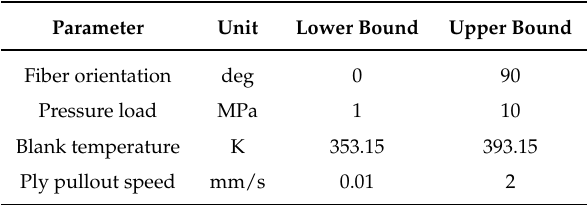
Table 2. Upper and lower bounds of the